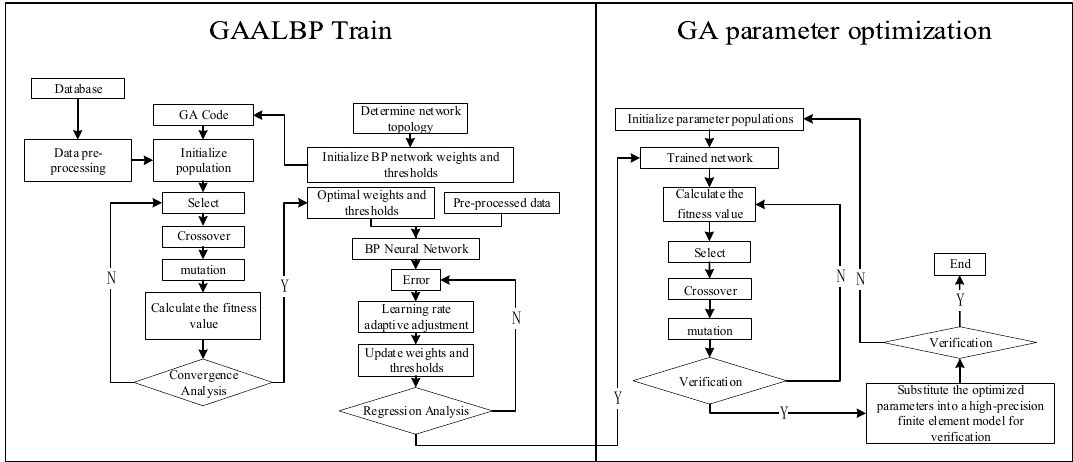
Figure 1. SMPO flow chart.